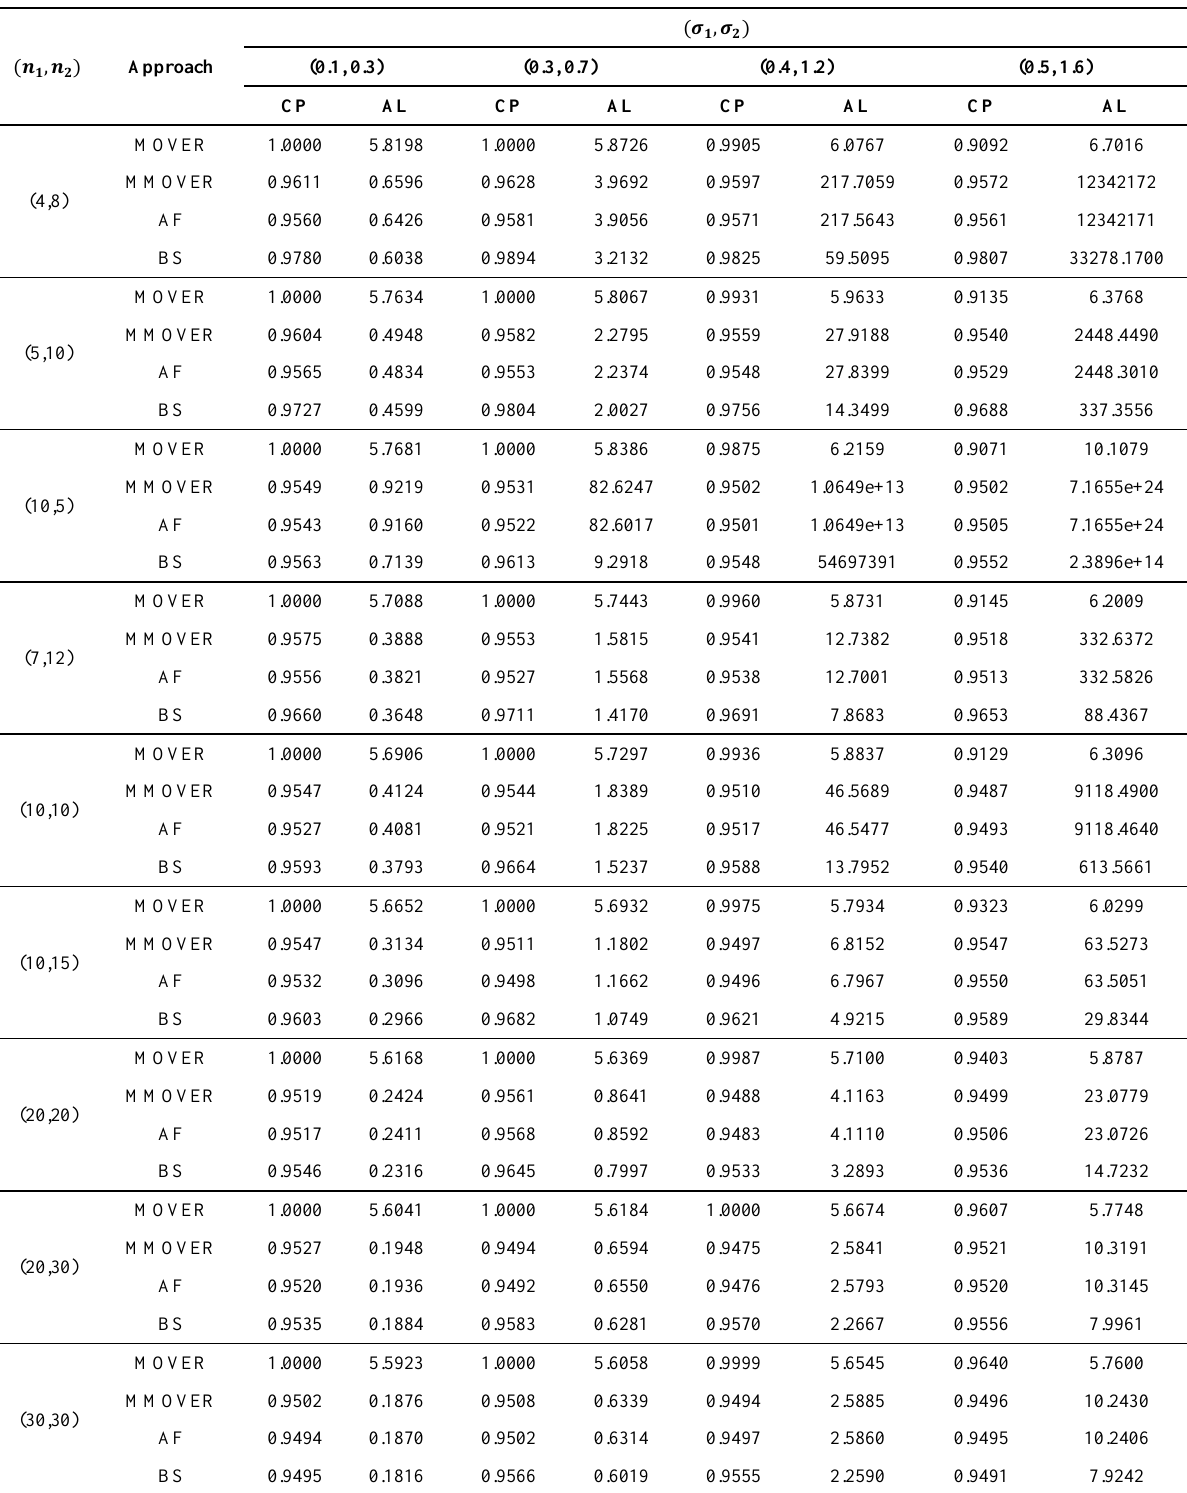
Table 2. The CP and AL of 95% two-sided confidence intervals for difference between the coefficients of variation of log- normal distributions as function of